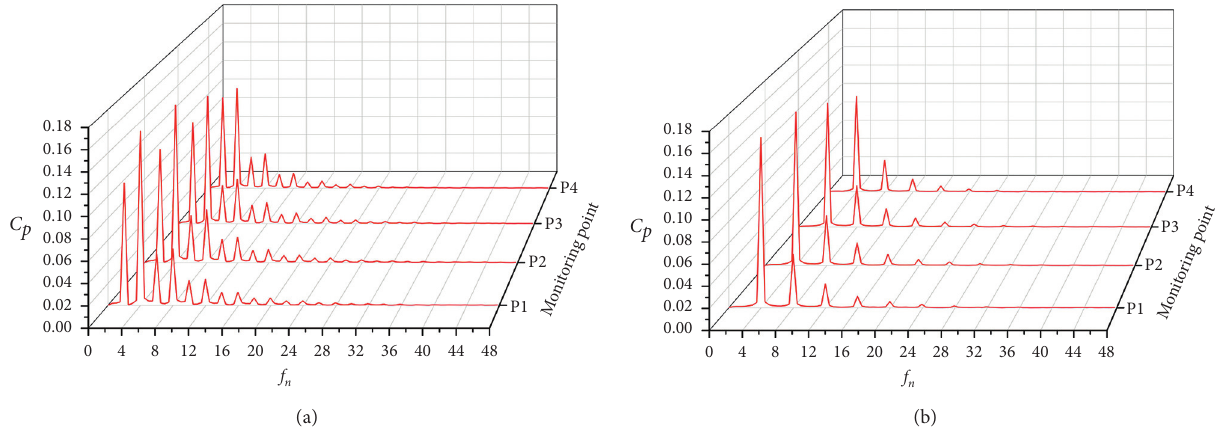
Figure 17: Frequency domain of each monitoring point at the impeller inlet ( Q � Q